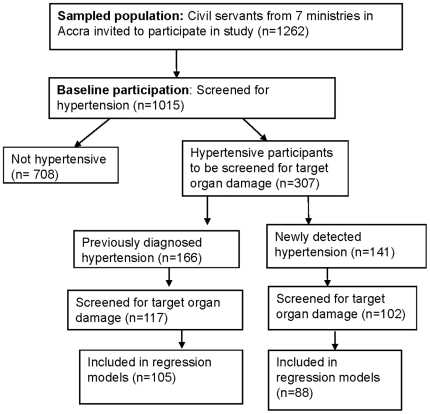
Flow diagram of study activities.